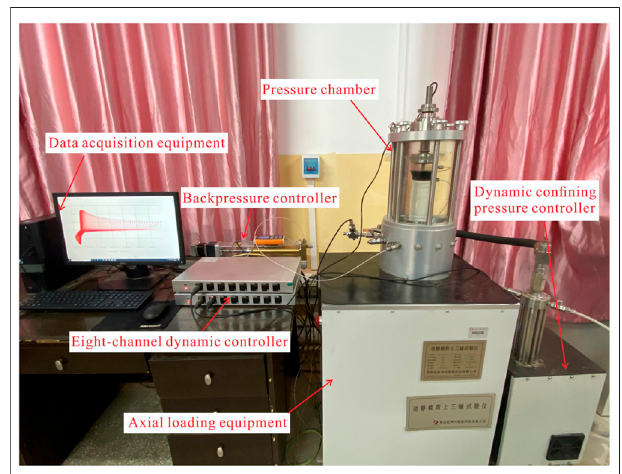
FIGURE 1 | KTL-DYN10 bidirectional dynamic triaxial